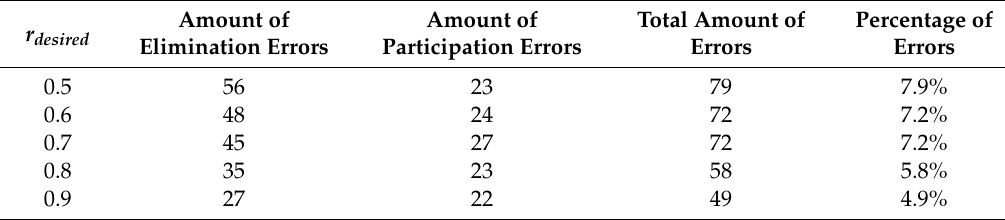
Table 2. Analysis of the number of errors in the identifications of the type of